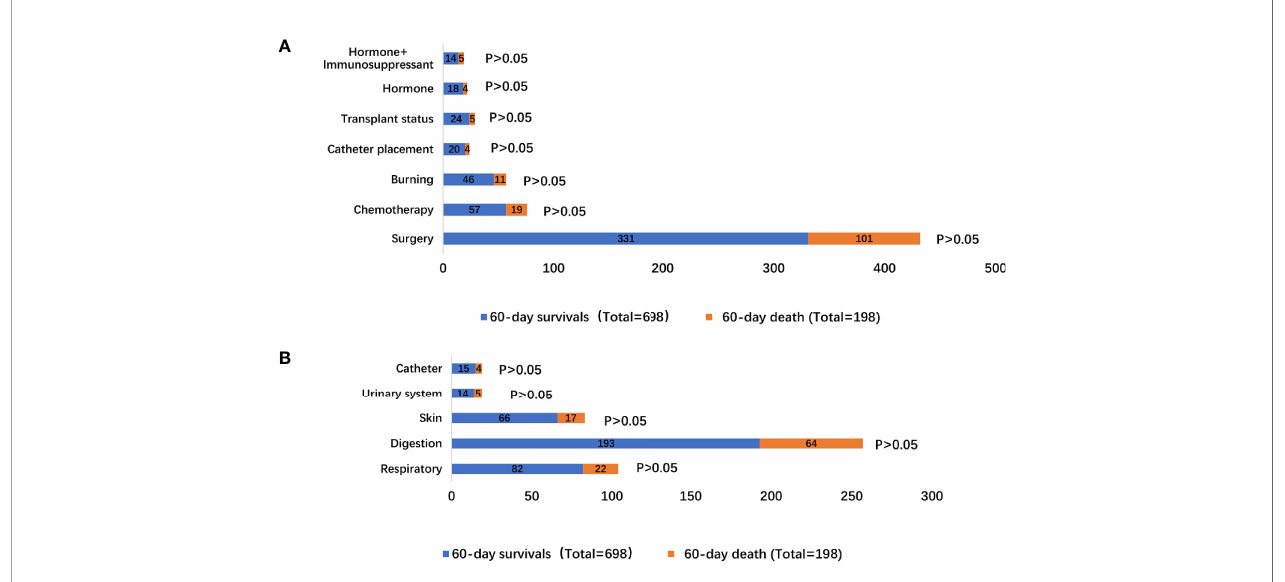
FIGURE 2 | Distribution of bloodstream infection according to 60-day survivals and 60-day death strati fi cations: (A) different inducement of infection; (B) resources of infectious